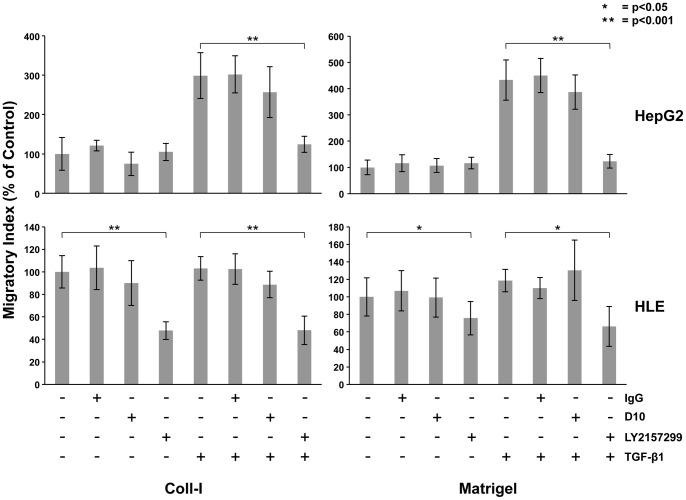
Comparison of the effect between LY2157299 and the fully humanized monoclonal antibody D10 in HCC cell migration.LY2157299 and D10 were tested in two different HCC cell lines, (A) HepG2 and (B) HLE, that were allowed to migrate on collagen I or matrigel. LY2157299, but not D10, was able to inhibit cell migration of both cell lines on both extracellular matrix components. An anti-isotype IgG was used as internal negative control. Results of representative experiments are shown, and values are expressed as mean ± standard deviation. *P<0.05 **P<0.001 versus TGF-β1.